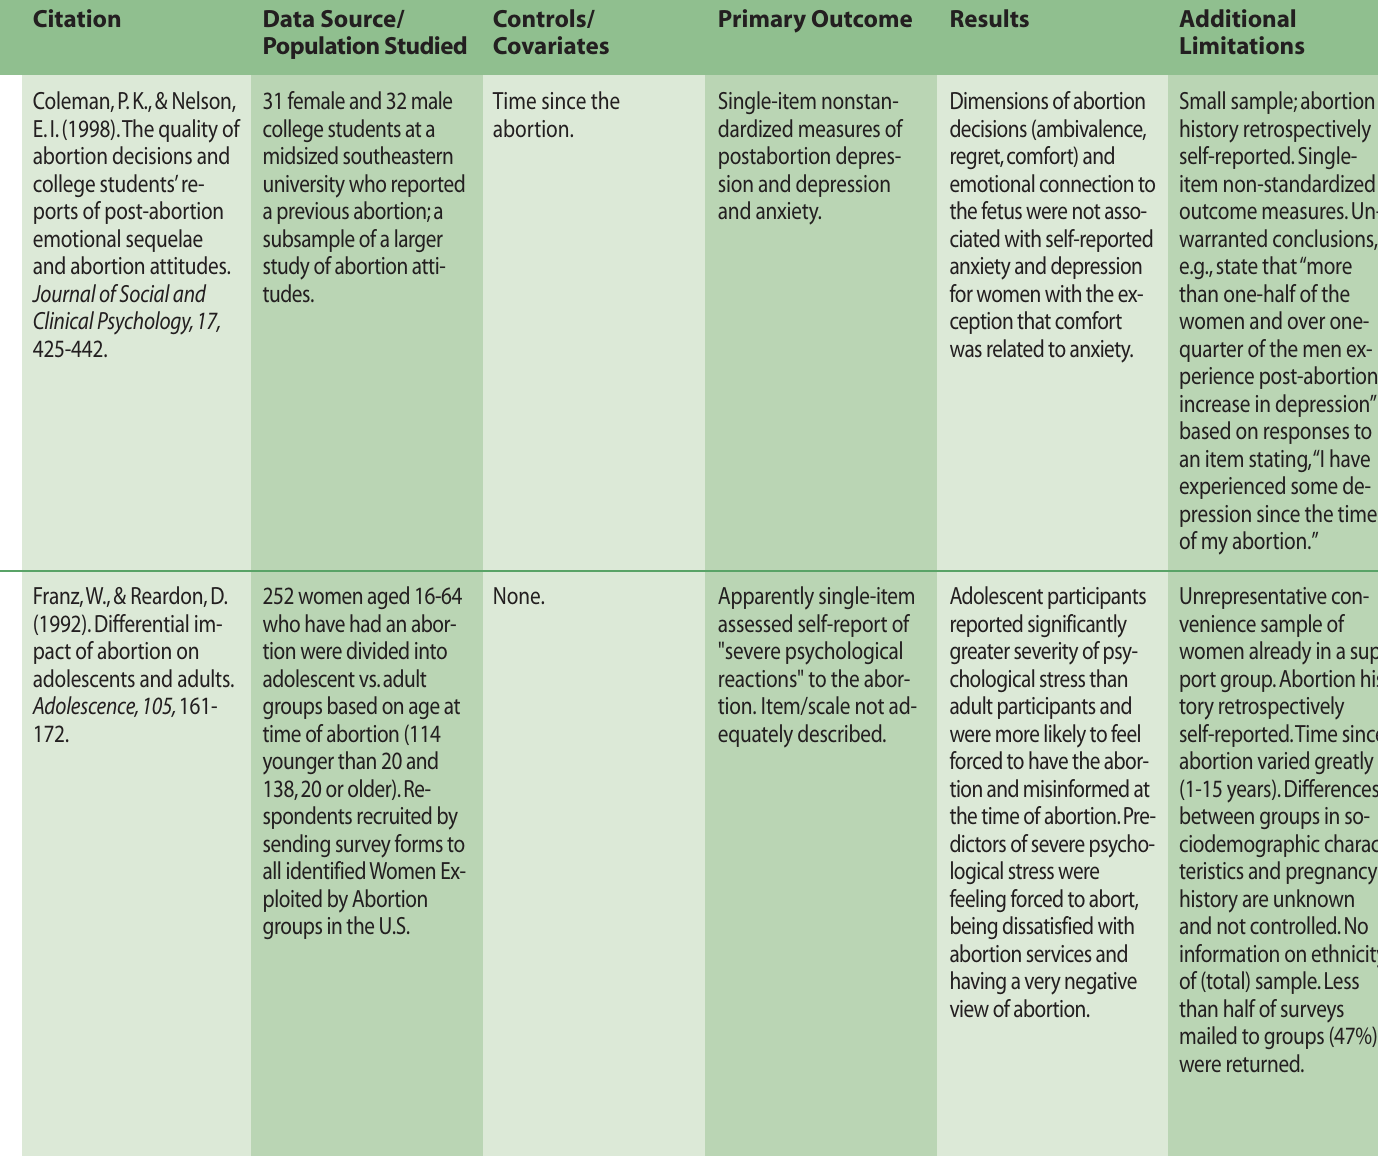
Table 5: U.S.Samples of Abortion Group(s) Only/No Comparison (continued) Retrospective Studies (all these studies lacked a preabortion measure of psychological functioning)